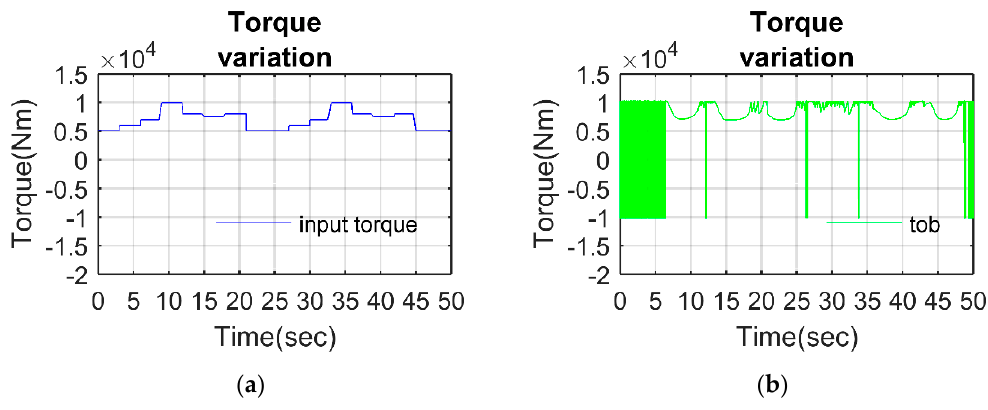
Figure 6. Output torques responses to input torque variations: ( a ) Input torque, ( b ) Tob